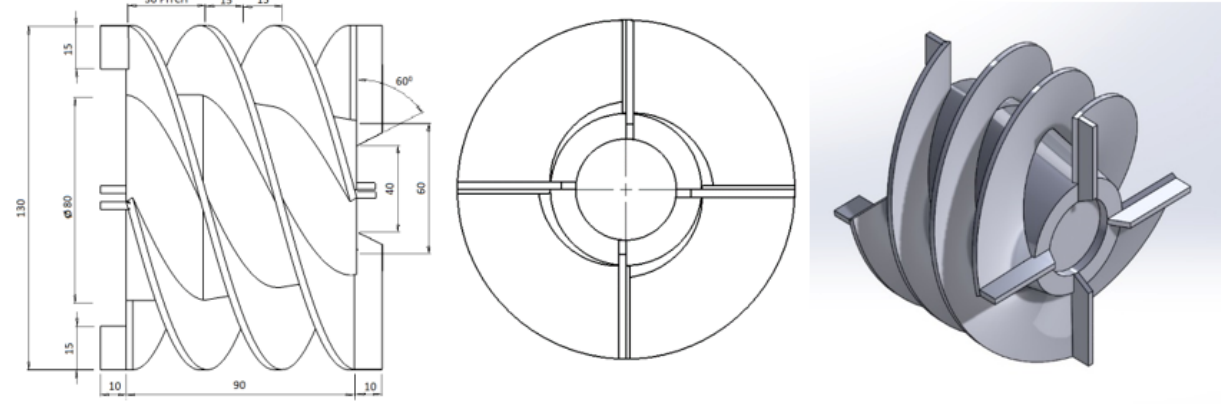
Figure 13. The geometric parameters and isometric view of the rotor with four equidistant blades and pitch length 30 mm.